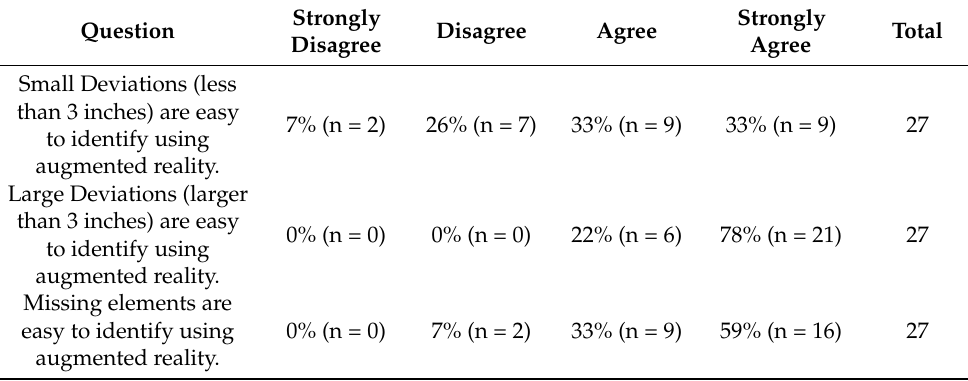
Table 5. Participant perceptions of ease of deviation identification by deviation